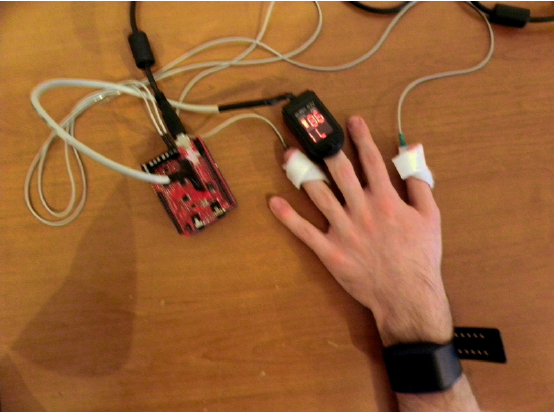
Figure 3. e-Health platform and Empatica E4 band, demonstration of devices equipped on the participant